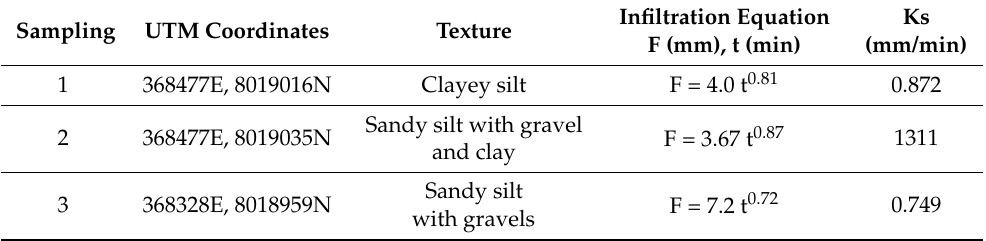
Table 5. Location of sampling points, texture, infiltration equation, and hydraulic conductivity at saturation